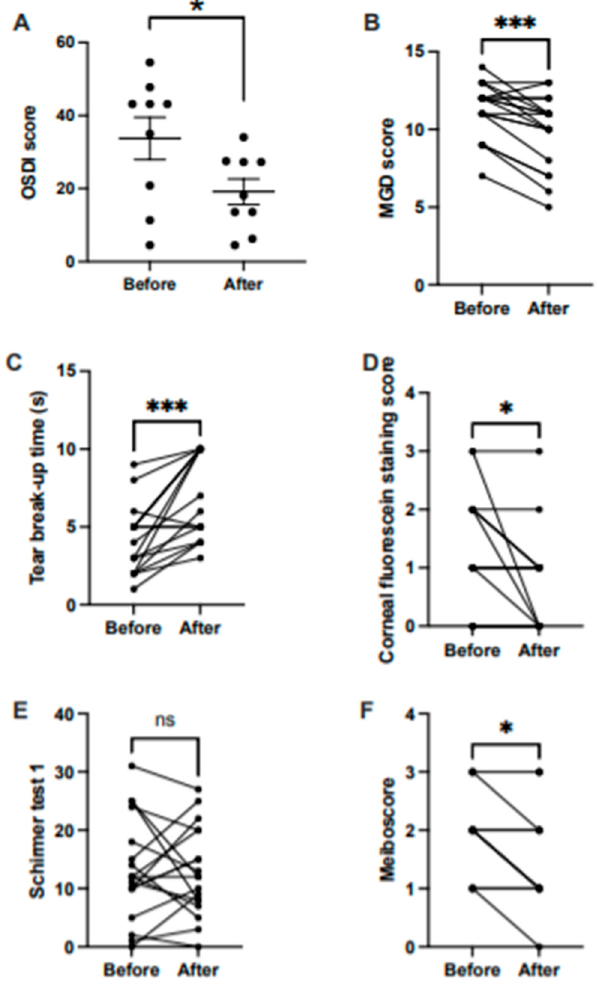
Figure 1. Treatment effect before and after treatment on ( A ) OSDI score (horizontal bars represent means, and error bars represent the standard error of the mean, SEM); ( B ) MGD score; ( C ) tear break ‐ up time; ( D ) corneal fluorescein staining score; ( E ) Schirmer 1 test; and ( F ) meiboscore. Lines shown in B, C, D, E, and F represent outcomes before and after treatment. s, seconds. * p < 0.05; *** p < 0.005; ns, non ‐ significant.